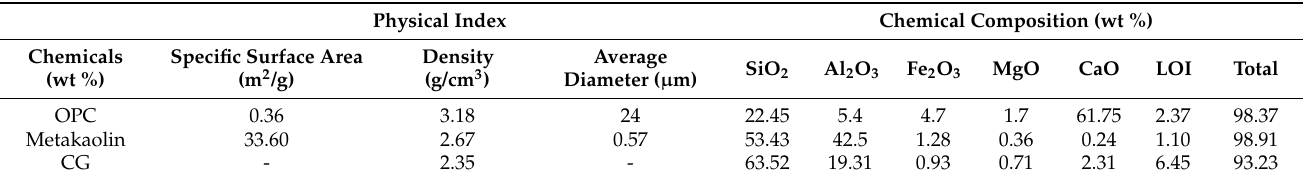
Table 1. The physical index and chemical composition of OPC and metakaolin.